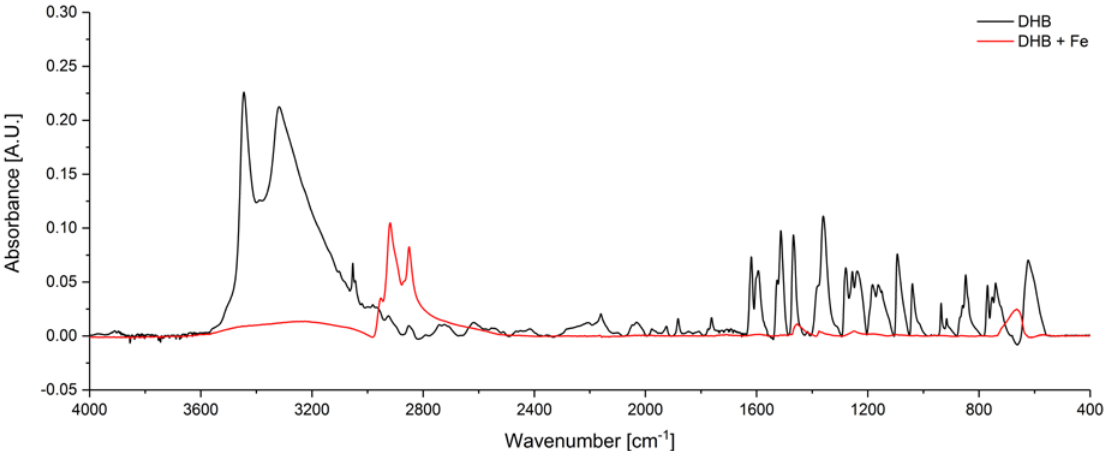
Figure 5. MIR spectrum of DHB before (black) and after (red) addition of Fe ions (10 µL with a concentration of 9.44 mg/mL). The absorption features of the hydroxylic groups from DHB and the aromatic ring vibrations decreased with Fe ions addition. New peaks from 2950 to 2850 cm − 1 indicate the formation of CH 2 within the cyclic ring.